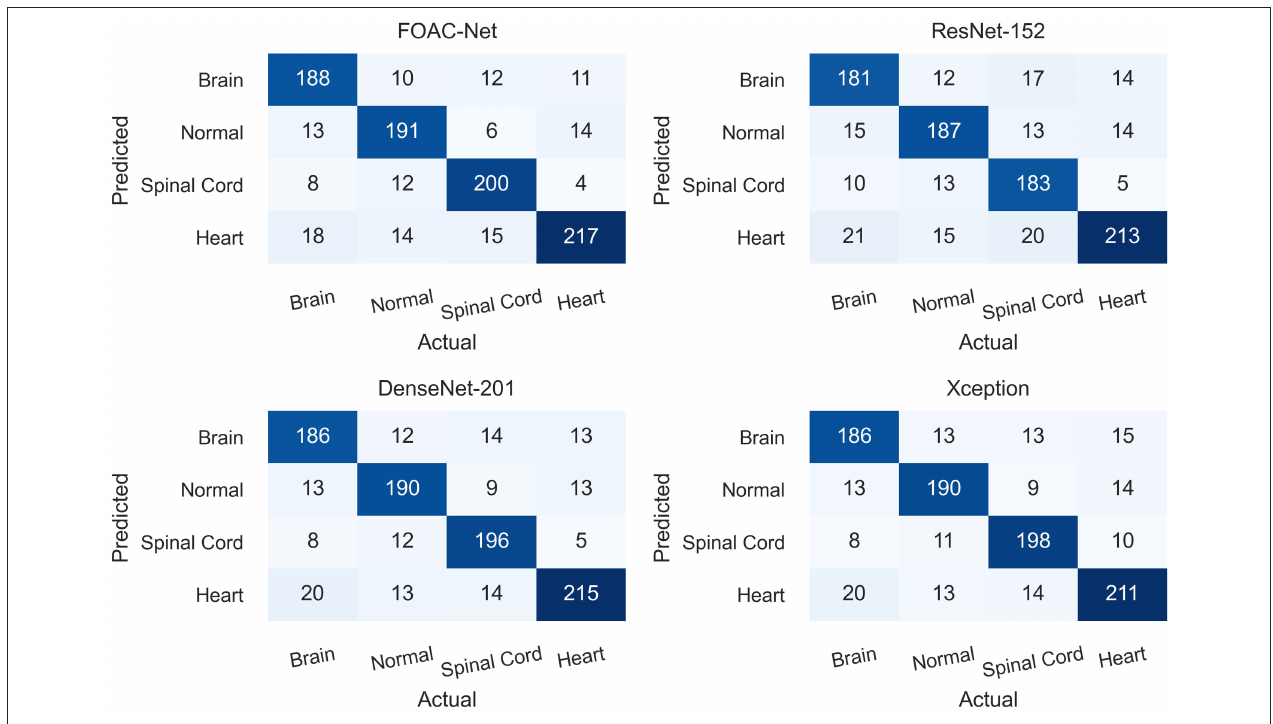
FIGURE 4 | Confusion matrix evaluating specific class performance on the proposed